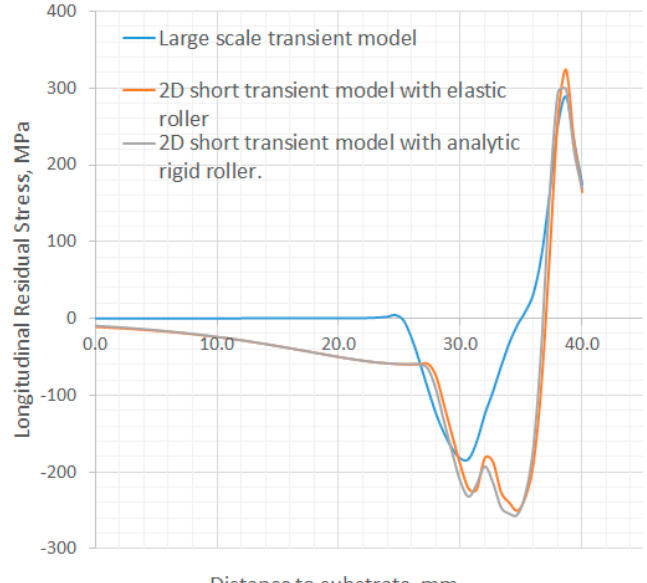
Figure 13. Longitudinal PS distributions on inspection planes.